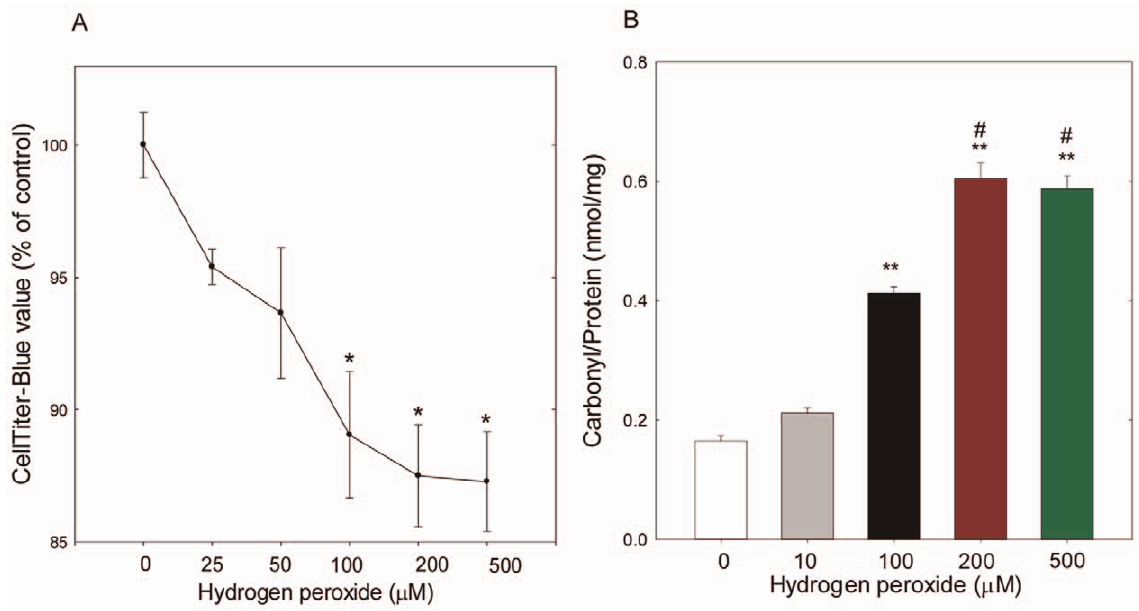
Newman–Keuls multiple comparison tests. Data are expressed as a percentage of the untreated control. n=5, mean 6 SEM, * p =0.002 vs. control, ** p , 0.001 vs. control, # p , 0.001 vs. 100 m M.